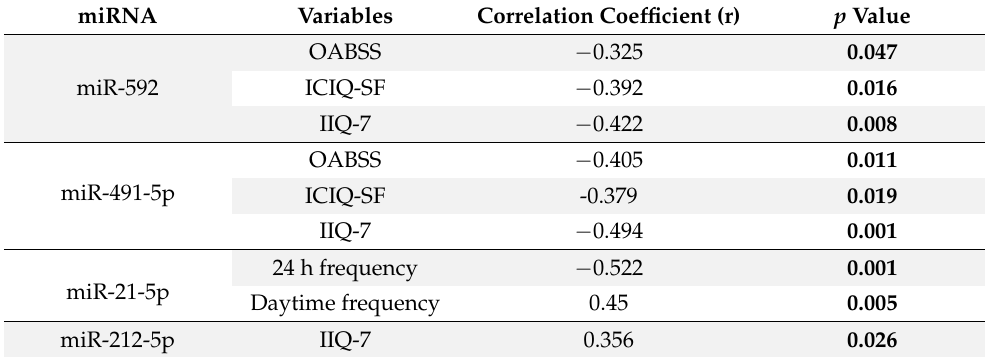
Table 4. Correlation between miRNAs and symptom questionnaires’ scores and voiding diary